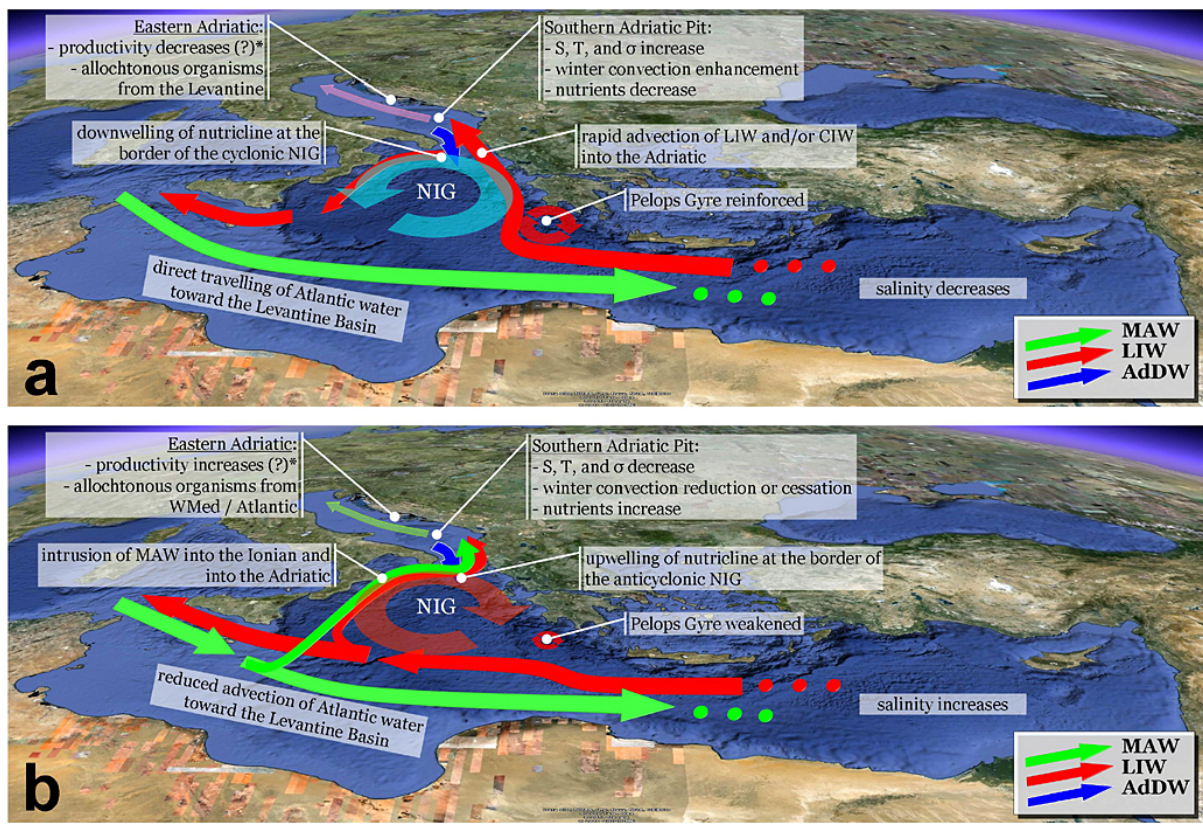
Fig. 5. Summary of the main characteristics of the Adriatic-Ionian BiOS and its impact on the area. (a) cyclonic NIG; (b) anticyclonic NIG. ∗ For more detailed explanations, see main text (Sect. 4.2). For acronyms, see main text.